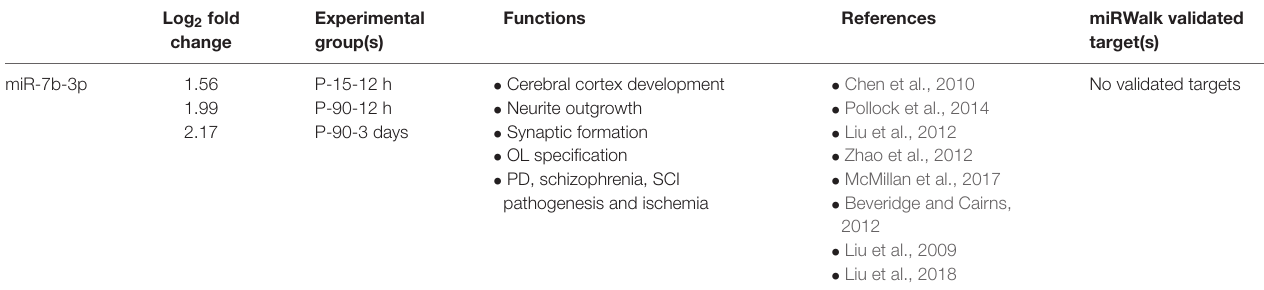
TABLE 1 | miR-7b-3p general information.